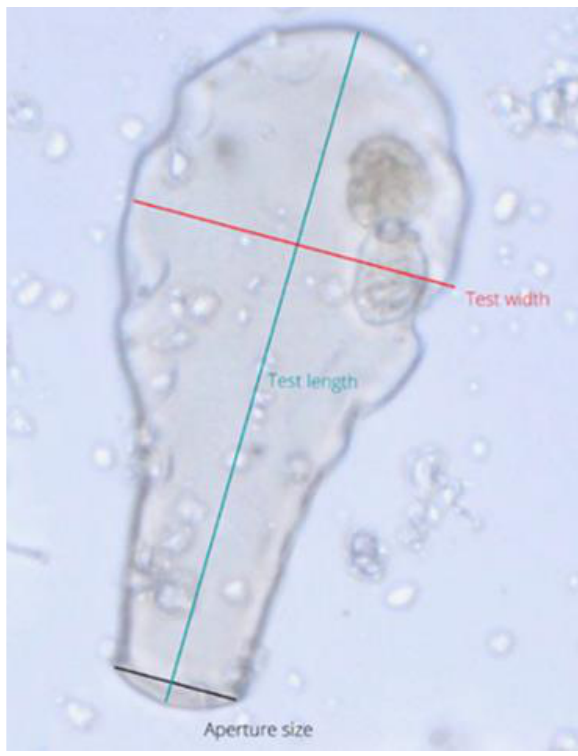
Figure 1. Test length, test width and aperture size in Hyalosphenia elegans